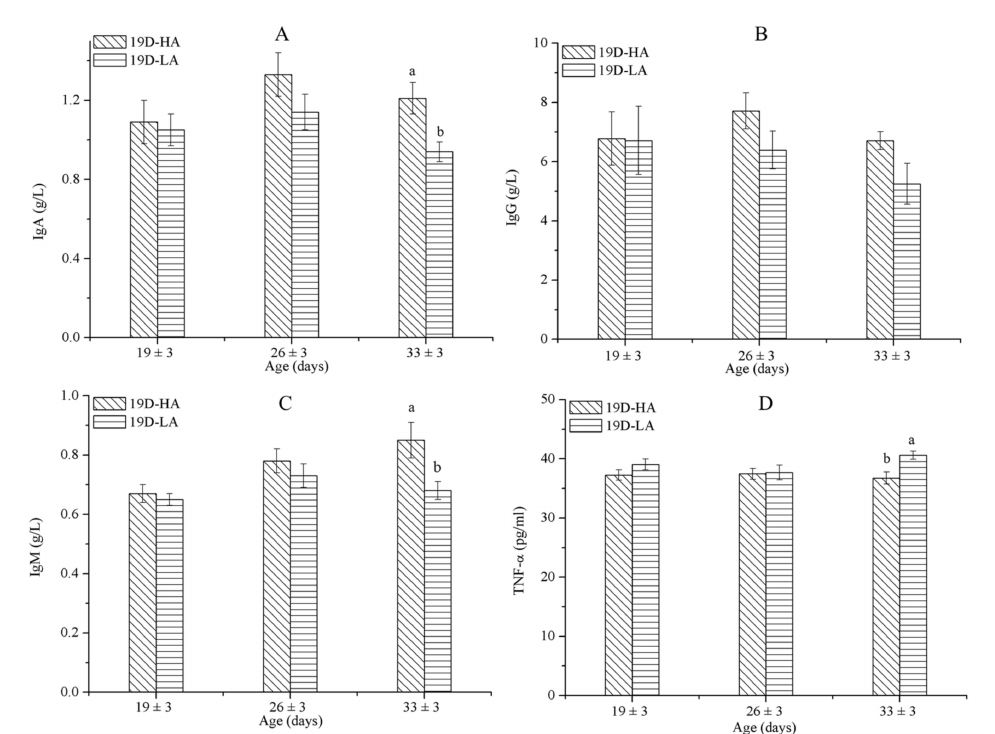
Figure 5. IgA ( A ), IgG ( B ), IgM ( C ), and TNF- α ( D ) concentrations among calves of D19-HA and D19-LA. Data represent mean ± SEM. a,b Values having different letters within the same column are significantly different ( p ≤